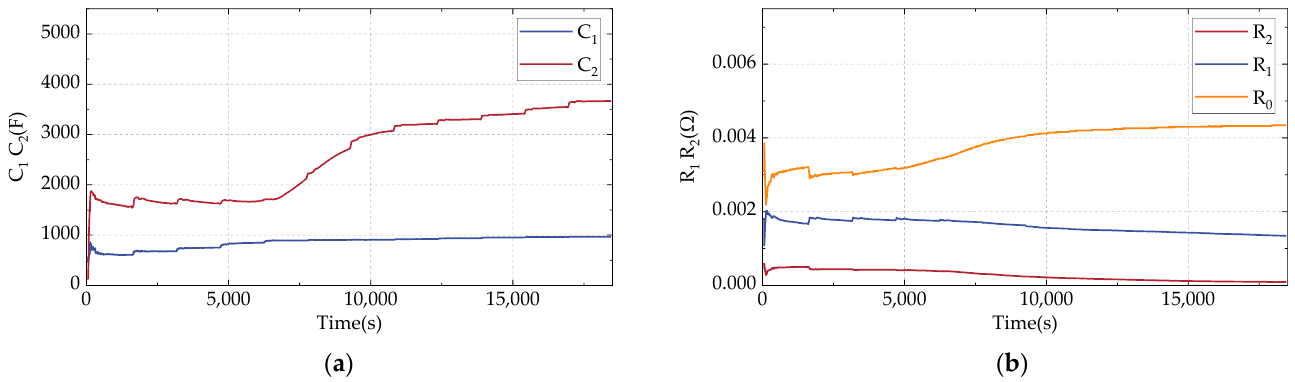
Figure 9. Parameter identification results of FFRLS algorithm under UDDS condition: ( a ) R 0 , R 1 , R 2 ; ( b ) C 1 , C 2 .